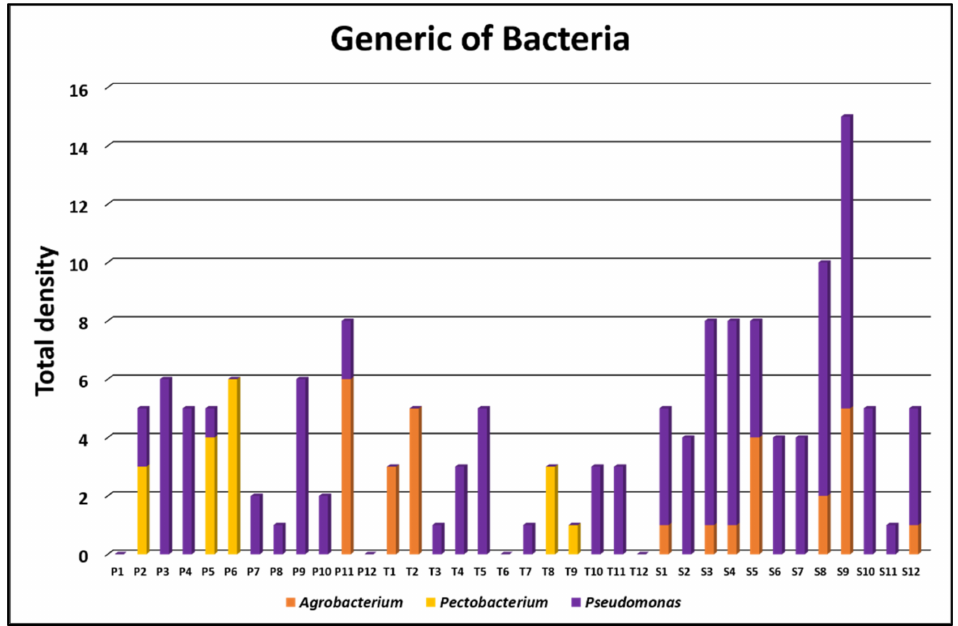
Figure 6. Total density of bacteria detected at 36 study sites according to generic division. P: paprika, T: tomato, S: